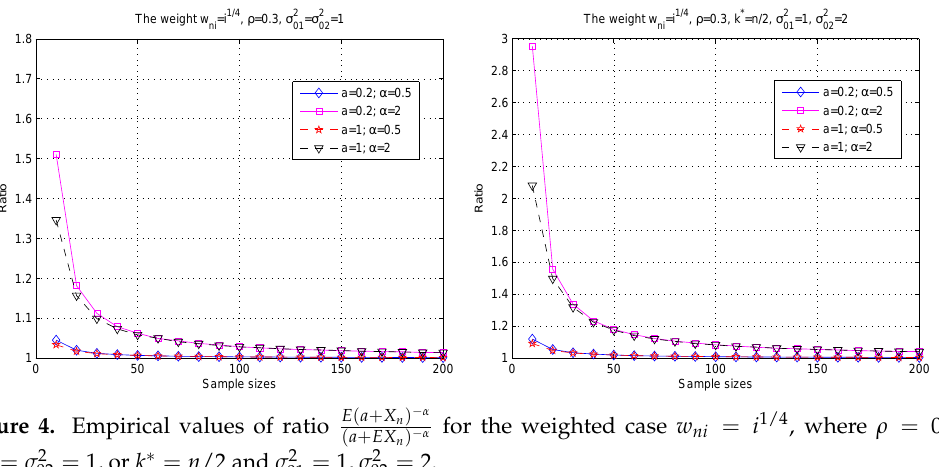
Figure 4. Empirical values of ratio E ( a + X n ) = σ 2 = 1, or k ∗ = n /2 and σ 2 σ 2 02 01